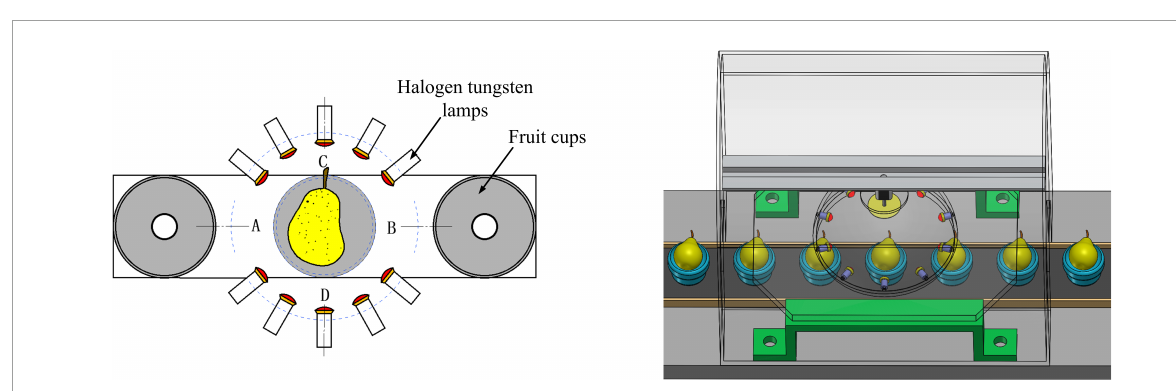
FIGURE2 Schematic diagram of light source (halogen tungsten lamps) layout.